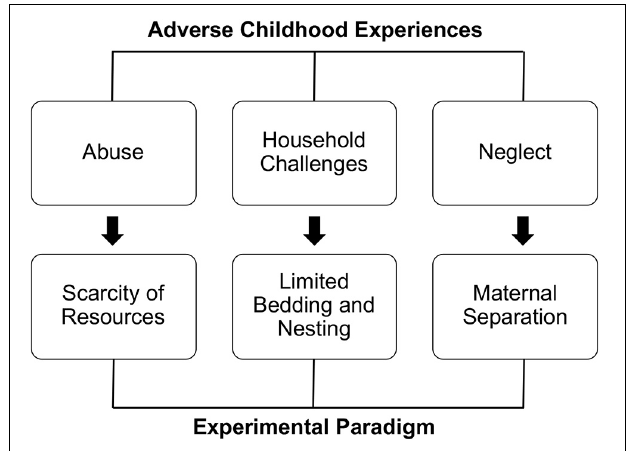
FIGURE 1 | Different kinds of ACEs require elective experimental